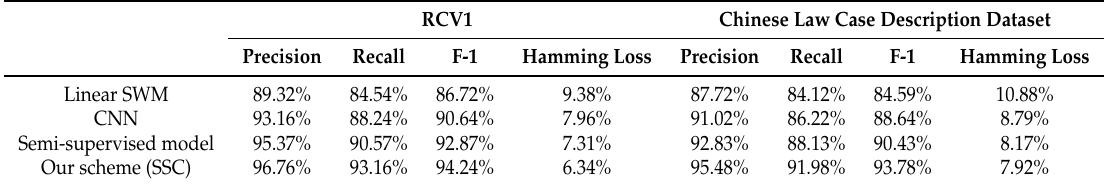
Table 3. Model performance in terms of precision, recall, F-1 score, and Hamming